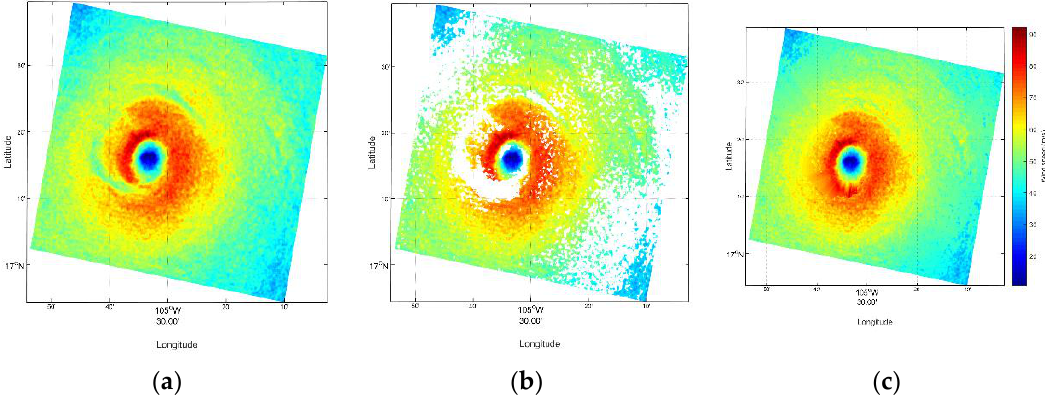
Figure 9. Wind field of Hurricane Patricia: ( a ) with rain; ( b ) with rain flagged; ( c ) after rain correction. Table 1. Statistics for VH SAR and HWIND wind speed before and after wind correction due to heavy rain contamination: ‘a’ c olumns show results without rain correction, ‘b’ columns show results with rain correction. The hurricane category is indicated following the Saffir-Simpson scale at the time of the SAR observation.